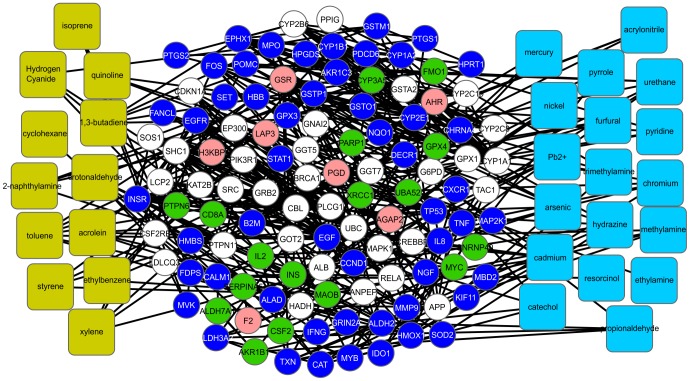
HBs found in the major CPI-PPI network.Betweenness and node degrees were assessed using the program CentiScaPe. Among the 143 HBs, 53 proteins are present in both tissues, reinforcing the idea of a prolonged effect of CS on embryonic development.